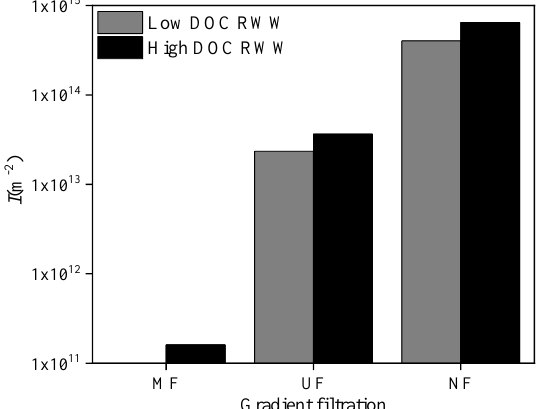
Figure 9. Cake layer fouling index, I, during gradient filtration of SWW.